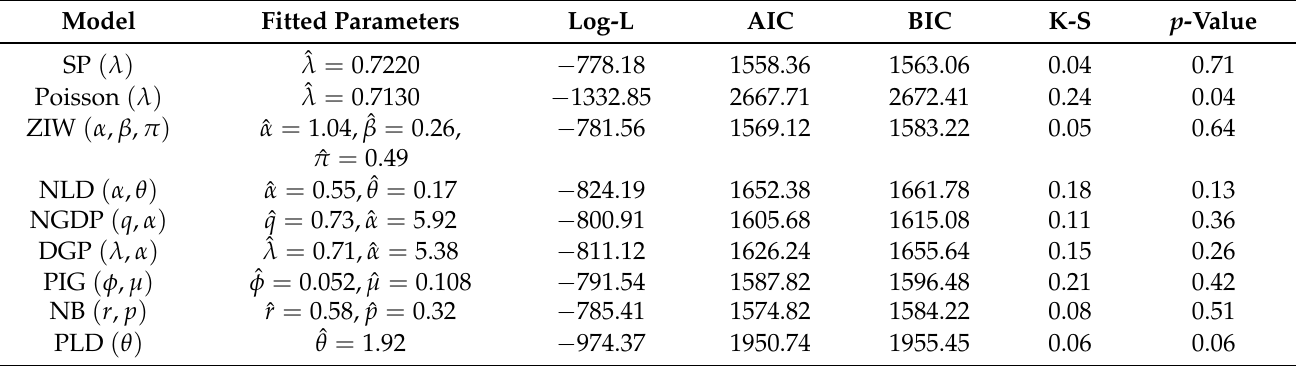
Table 2. Comparing model fits for the parasite intensity data.